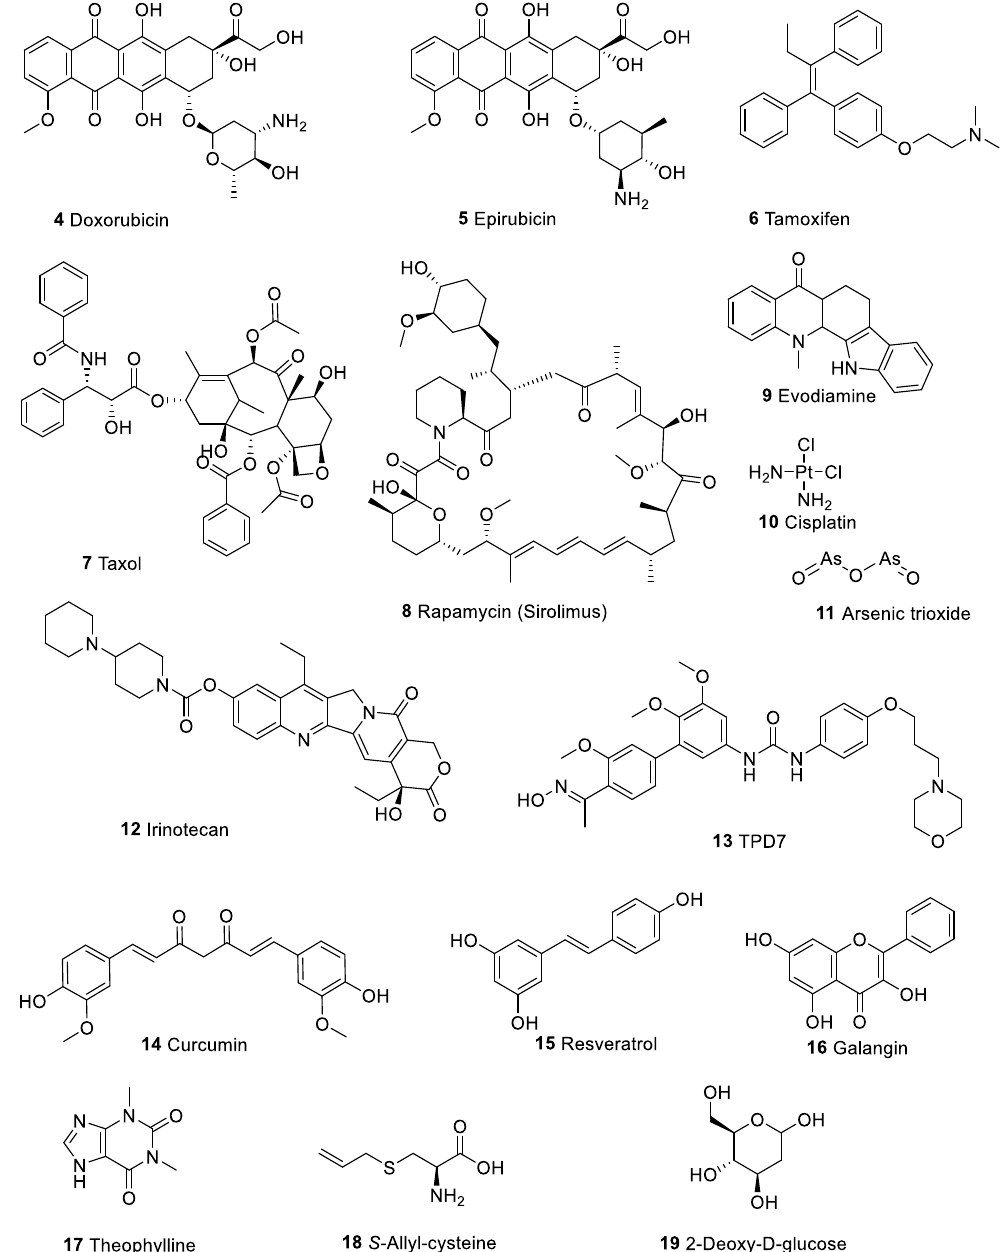
Figure 2. Anticancer agents that showed positive interaction and pharmacological efficacy enhancement when combined with berberine.